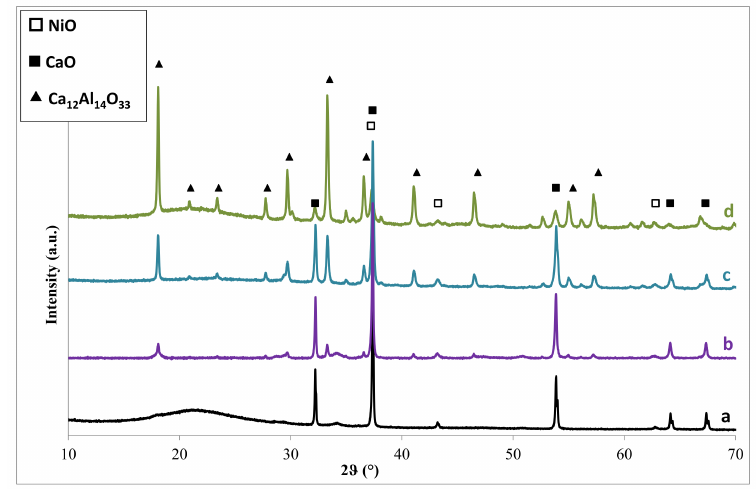
Figure 3. XRD patterns of (a) C100Ni3, (b) C85Ni3, (c) C56Ni3, and (d) MayNi3.